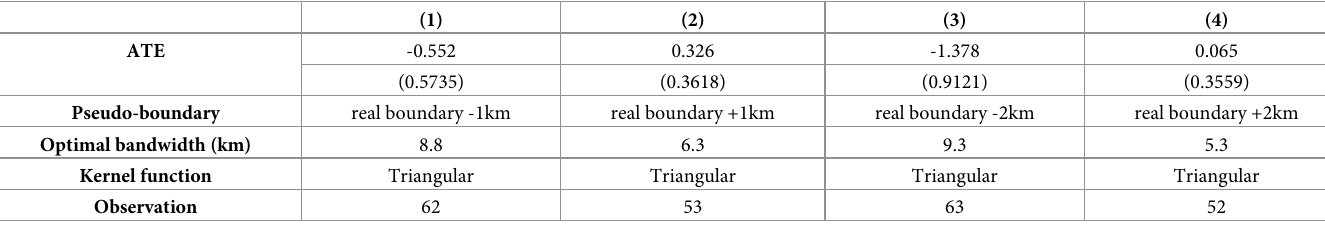
Table 6. Placebo test with